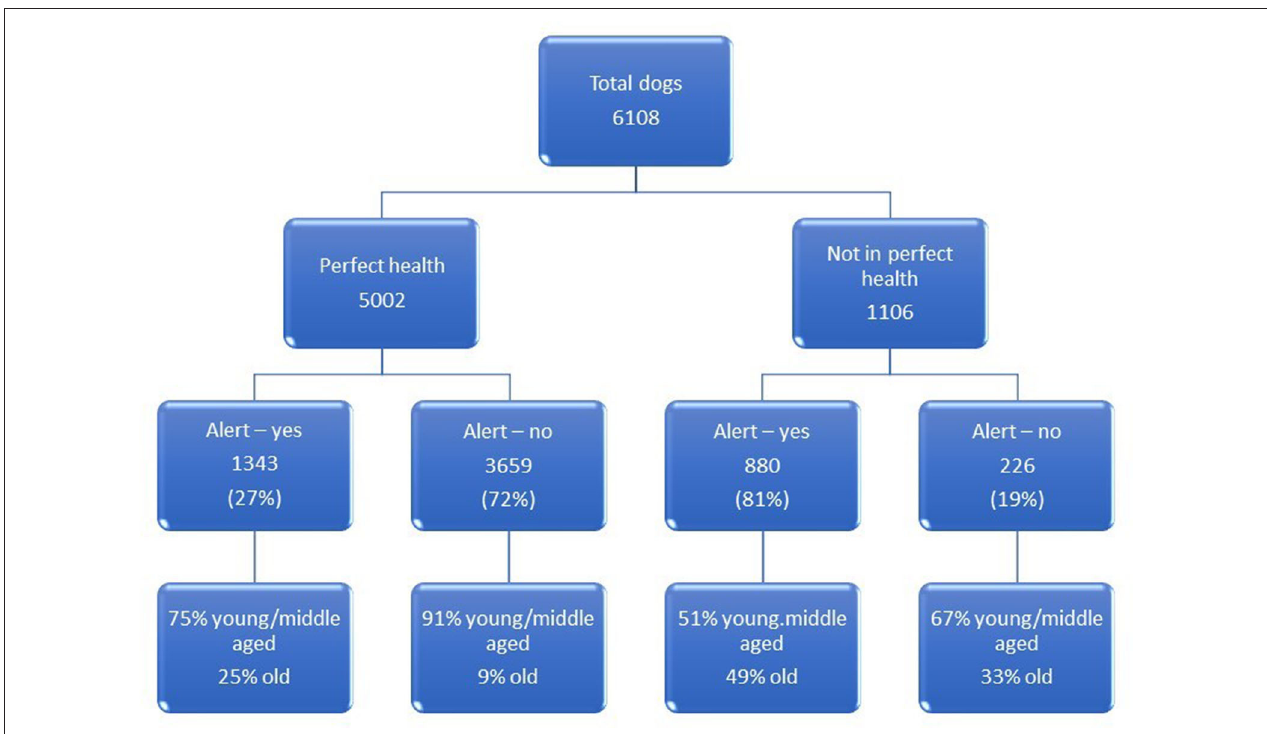
FIGURE 6 | An overview of the owners’ impression of health status for the 6,108 dogs along with details of their age category and whether the Vet flag was triggered.